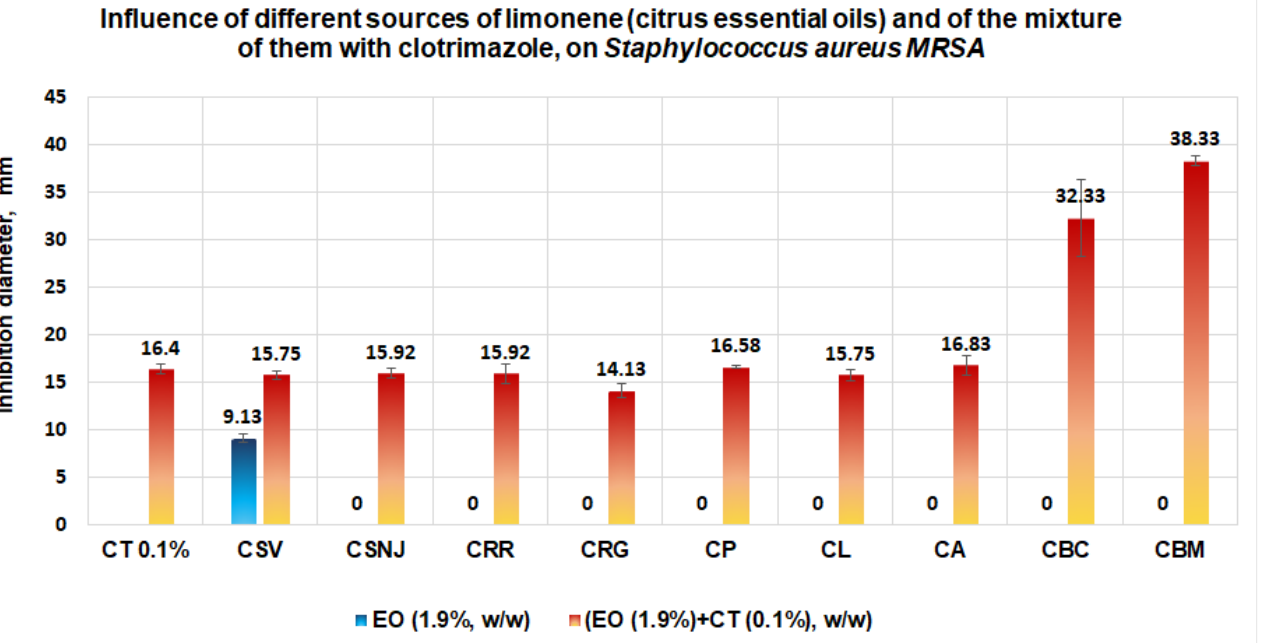
24 of 32 Figure 13. Influence of different sources of limonene (citrus essential oil, 1.9%, w/w) and of the mix-